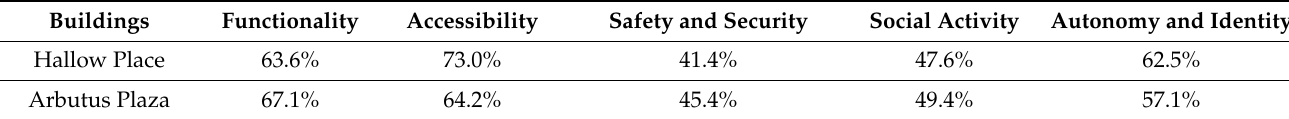
Table 3. Overall scoring of AIRP concepts per THP